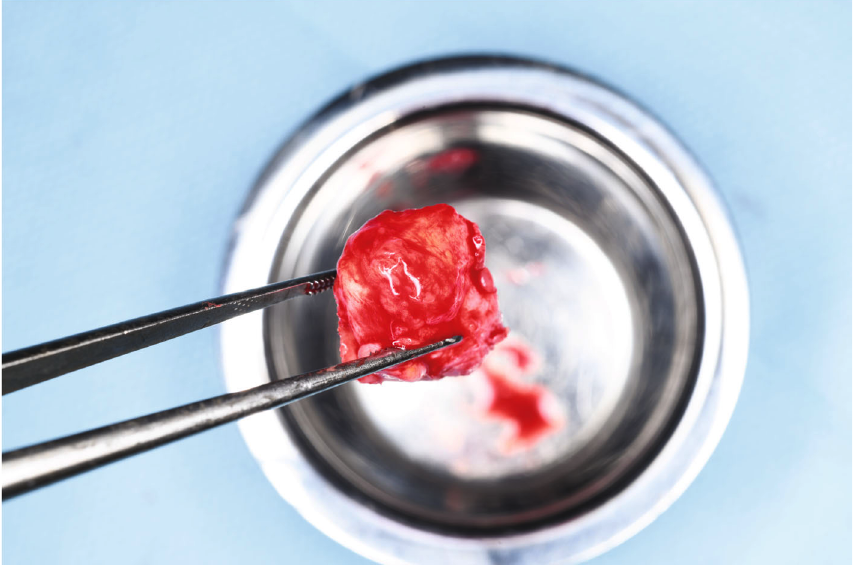
Figure 8: A triple graft containing a layer of soft tissue and cortical and cancellous bone.